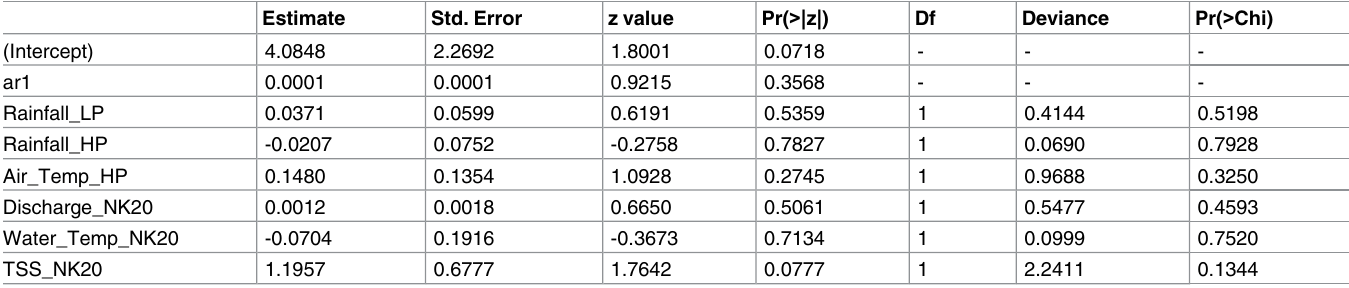
Table 5. Effect of environmental variables on E . coli counts in NK20from May 2011 to December2012. The last 3 columns present the results of the LRT and show the significances of each variable, correcting for the potential confounding effects of the other variables. ar1 is the 1-step laggedFIB variable.